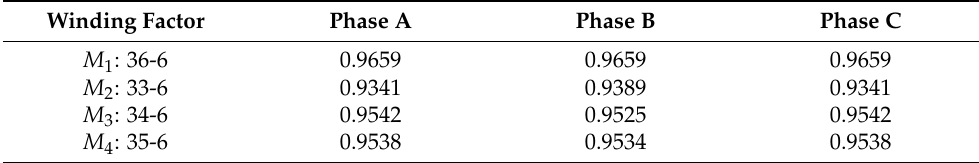
( d ) Figure 5. Air − gap flux density waveforms of four motors without flux barrier: ( a ) M 1 : 36 − slot and 6 − pole; ( b ) M 2 : 33 − slot and 6 − pole; ( c ) M 3 : 34 − slot and 6 − pole; ( d ) M 4 : 35 − slot and 6 − pole.